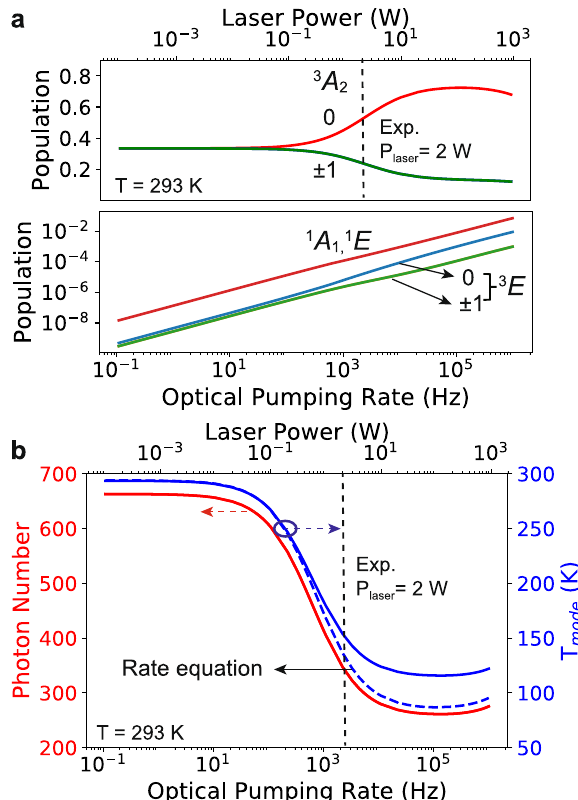
Fig. 3 Steady-state cooling of the NV spins and the microwave resonator mode. a , b Steady-state values of the same quantities as shown in Fig. 2a, b as function of the optical pumping rate ξ (lower axis) or the laser power (upper axis). The laser power 2 W, as used in Fig. 2 and the experiment 9 , is marked with the vertical dashed line. There is no microwave driving fi eld, and other parameters are speci fi ed in the Supplementary Table